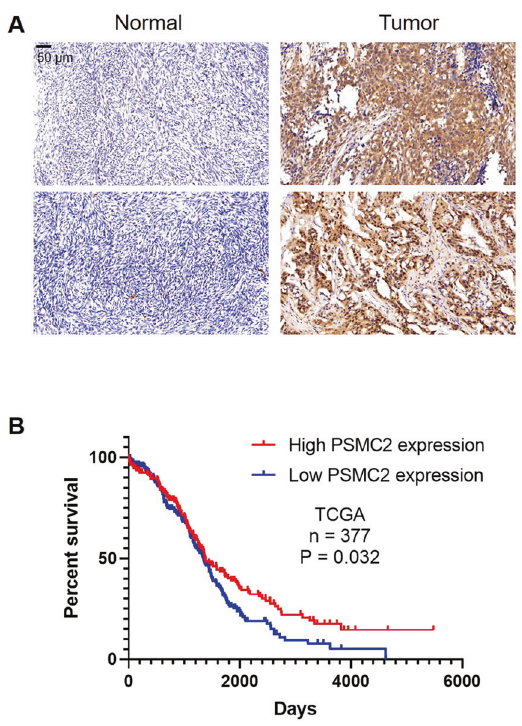
Fig. 1 Upregulation of PSMC2 in ovarian cancer predicts poor prognosis. A IHC analysis was used to determine the expression levels of PSMC2 in ovarian cancer tissues and normal tissues. B PSMC2 expression and survival data were collected from TCGA database for conducting Kaplan – Meier survival analysis.